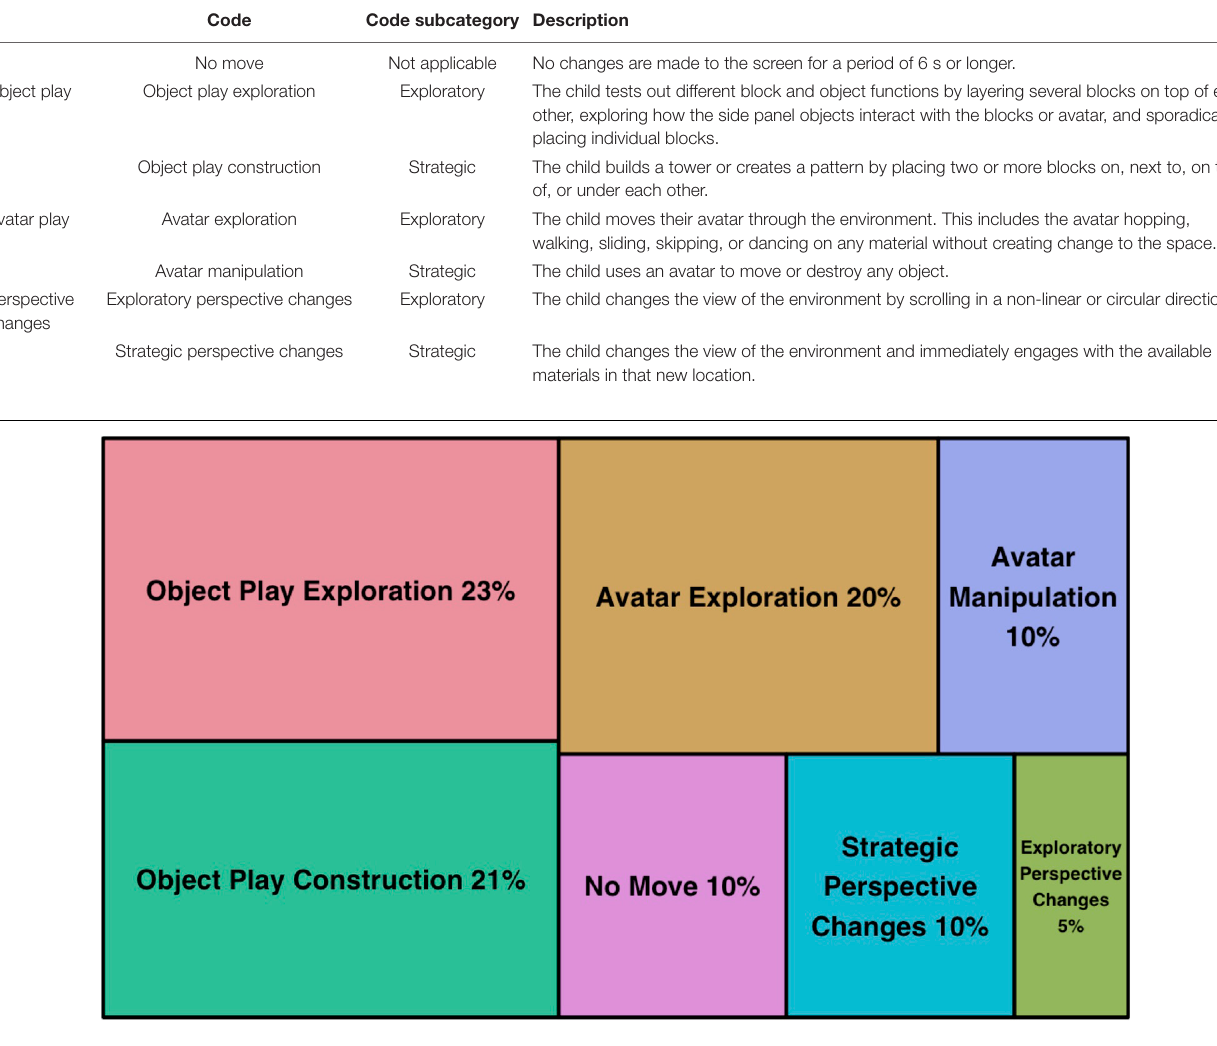
subcategory was Object Play Exploration and was coded